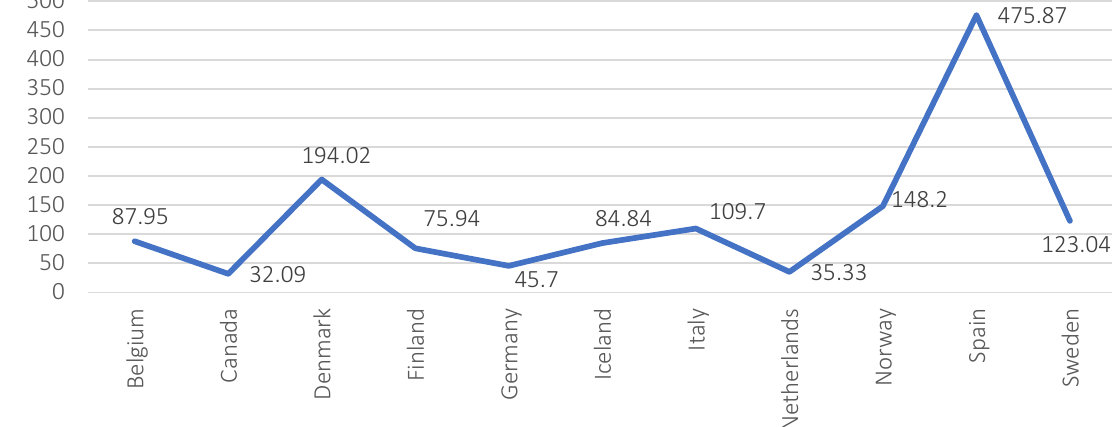
Figure 1. Increase in the number of bankruptcies in certain countries, % (the percentage of increase in the number of bankruptcies in the fourth quarter of 2020 by individual countries of the world (2007 is taken as